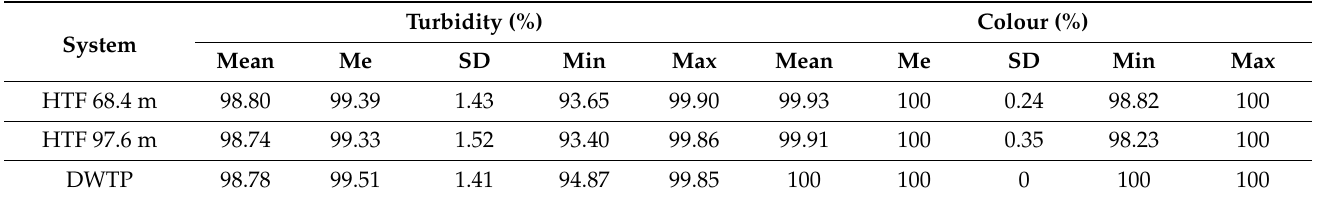
Table 7. Statistical Parameters of the Turbidity and Color Removal Efficiency after HTF + Settler + Filter in the Studied